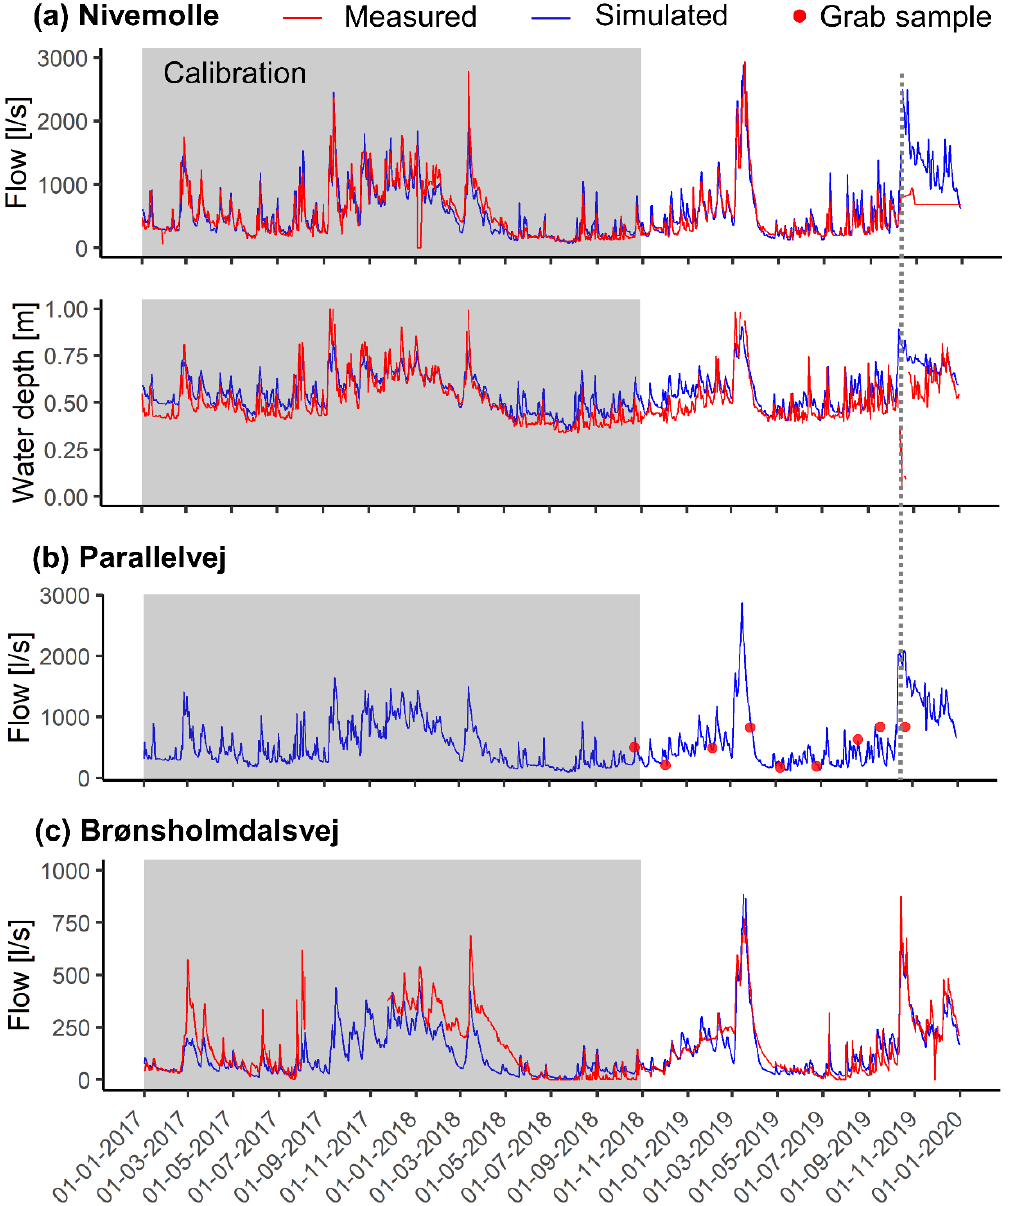
Figure 4. Selected results of flow and depth simulations for Usserød stream ( a , b ) and the Donse tributary ( c ) compared to available measured data. Other simulation results can be found in Figure S7 (Usserød flow), Figure S8 (Usserød water depth), Figure S9 (Donse tributary flow).